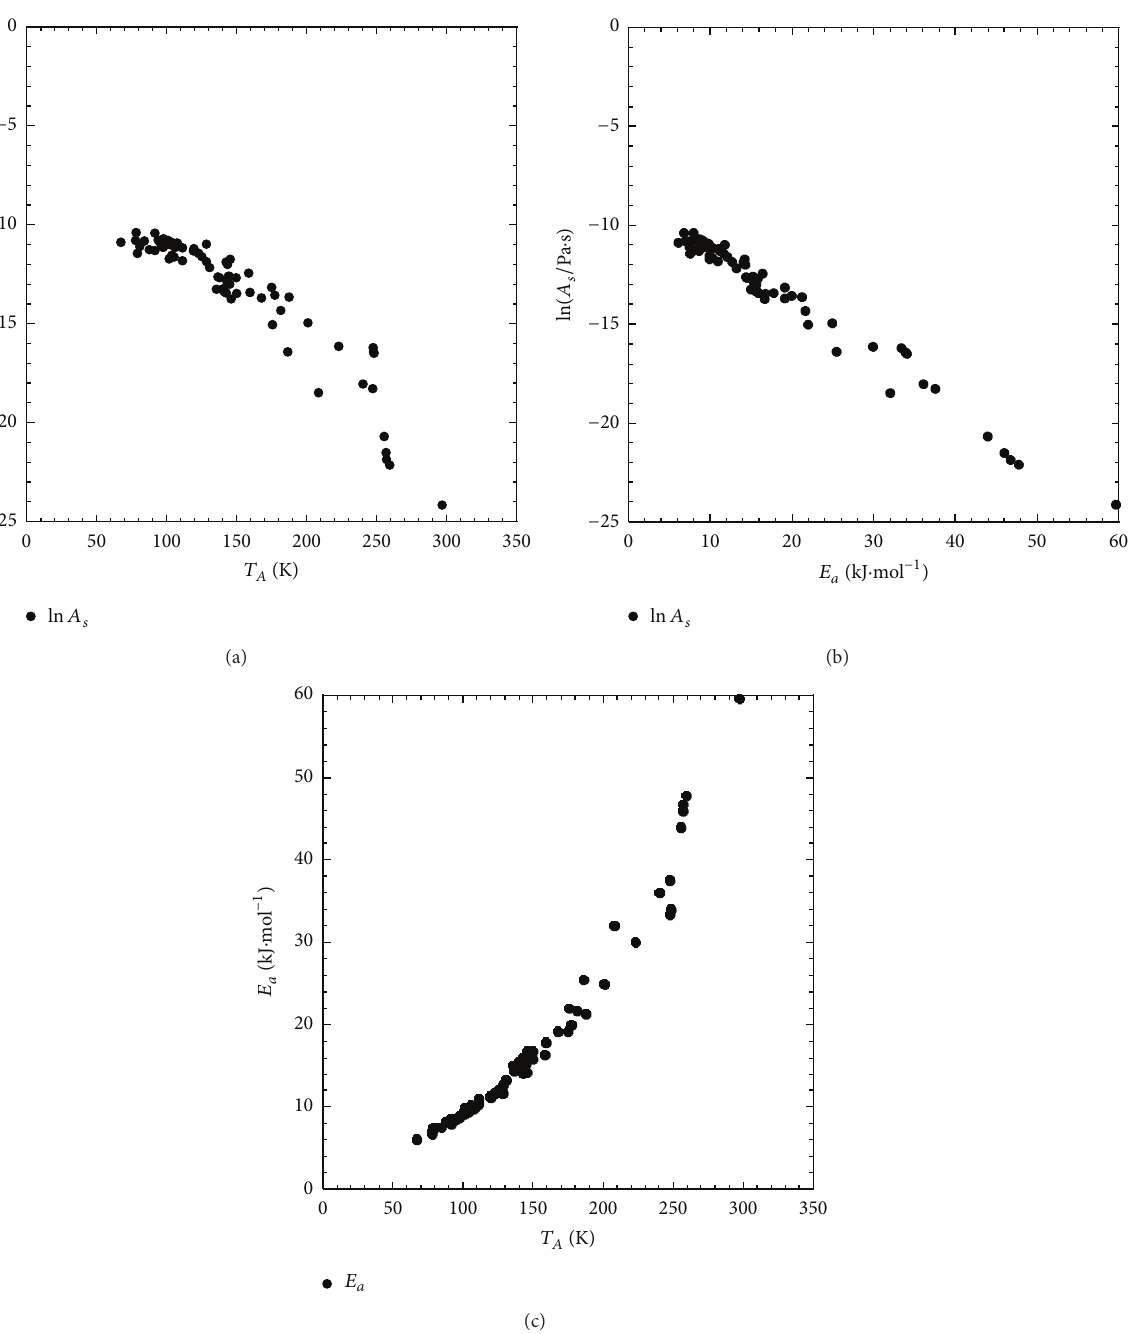
Figure 3: Scatter plots for pairwise correlations between Arrhenius